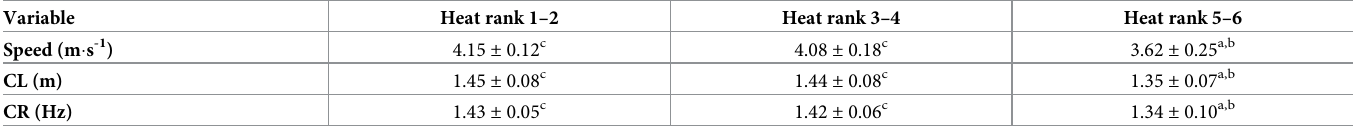
Table 3. Cycle characteristics in the diagonal sub-technique during the final uphill segment in a 1.7-km classical sprint cross-country skiing race for elite male ski- ers. Values are mean ± SD [N = 27]. Variable